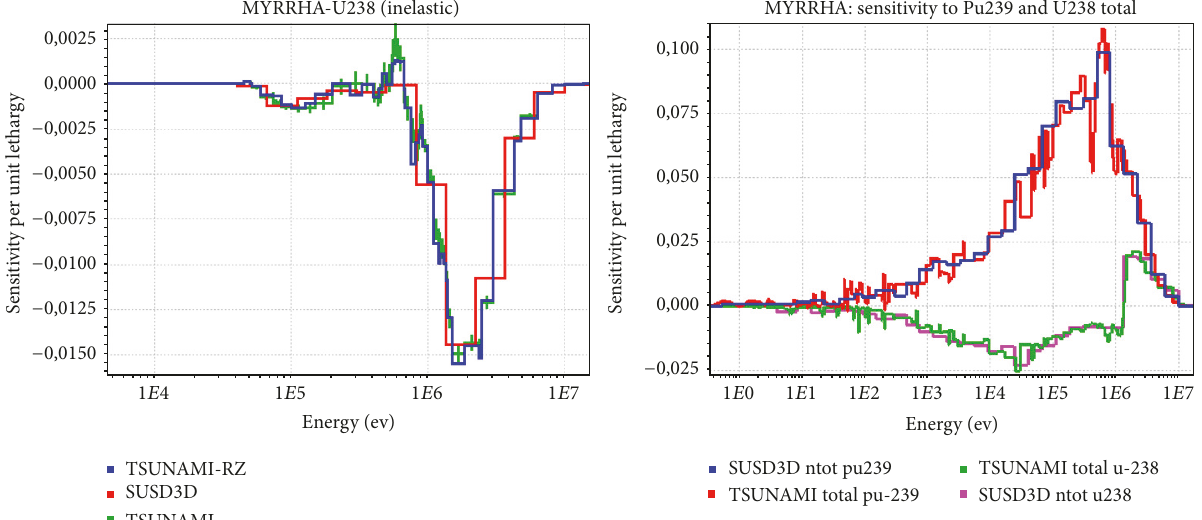
Figure 13: Sensitivity of 𝑘 eff calculated using the SUSD3D and TSUNAMI codes for the MYRRHA reactor.